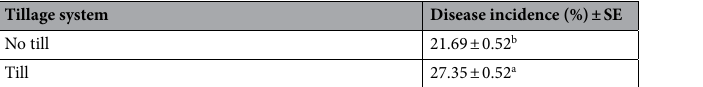
Table 5. Mean leaf spot disease incidence in the tillage systems. SE Standard Error. a, b means in the same column with the same superscript are not significantly different at p < 0.05 (DMRT).